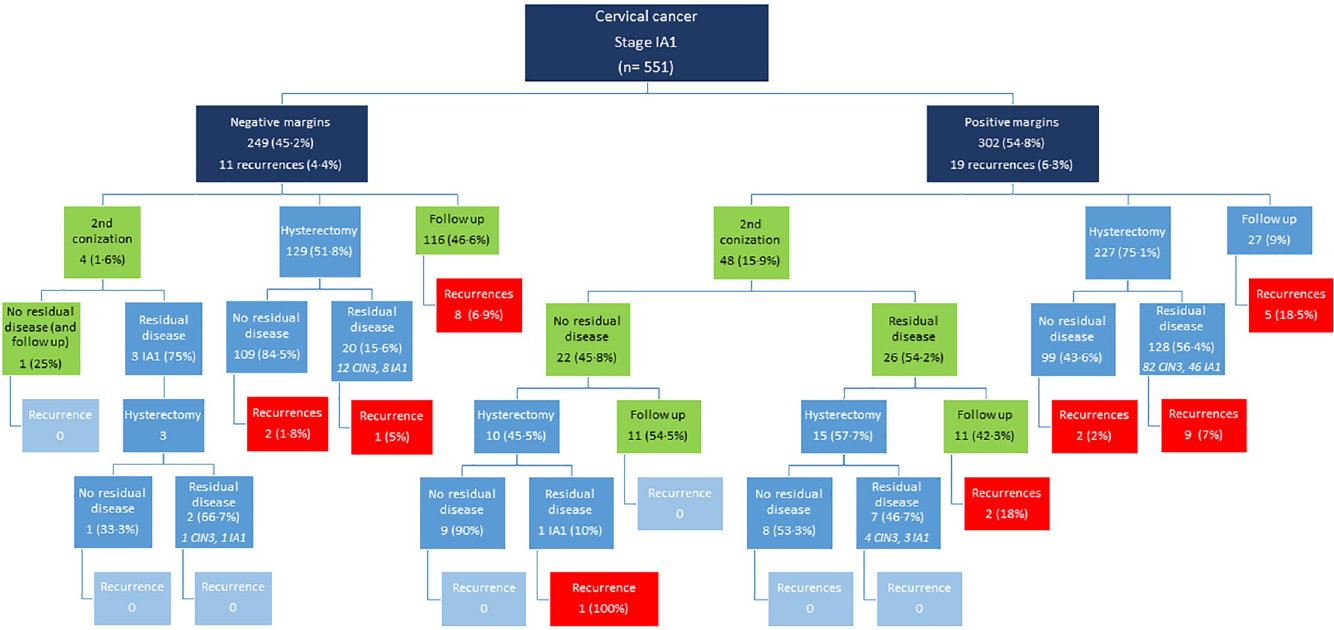
Fig 1. Predictive value (PV) for conization height in women younger than 40 yo with squamous cell carcinoma of the cervix stage IA1. A. Negative PV value for compromising surgical margins (n = 233). B. Negative PV for residual disease (CIN3 or worse) based in 67 uteri specimens after hysterectomy with previous negative conization margins.